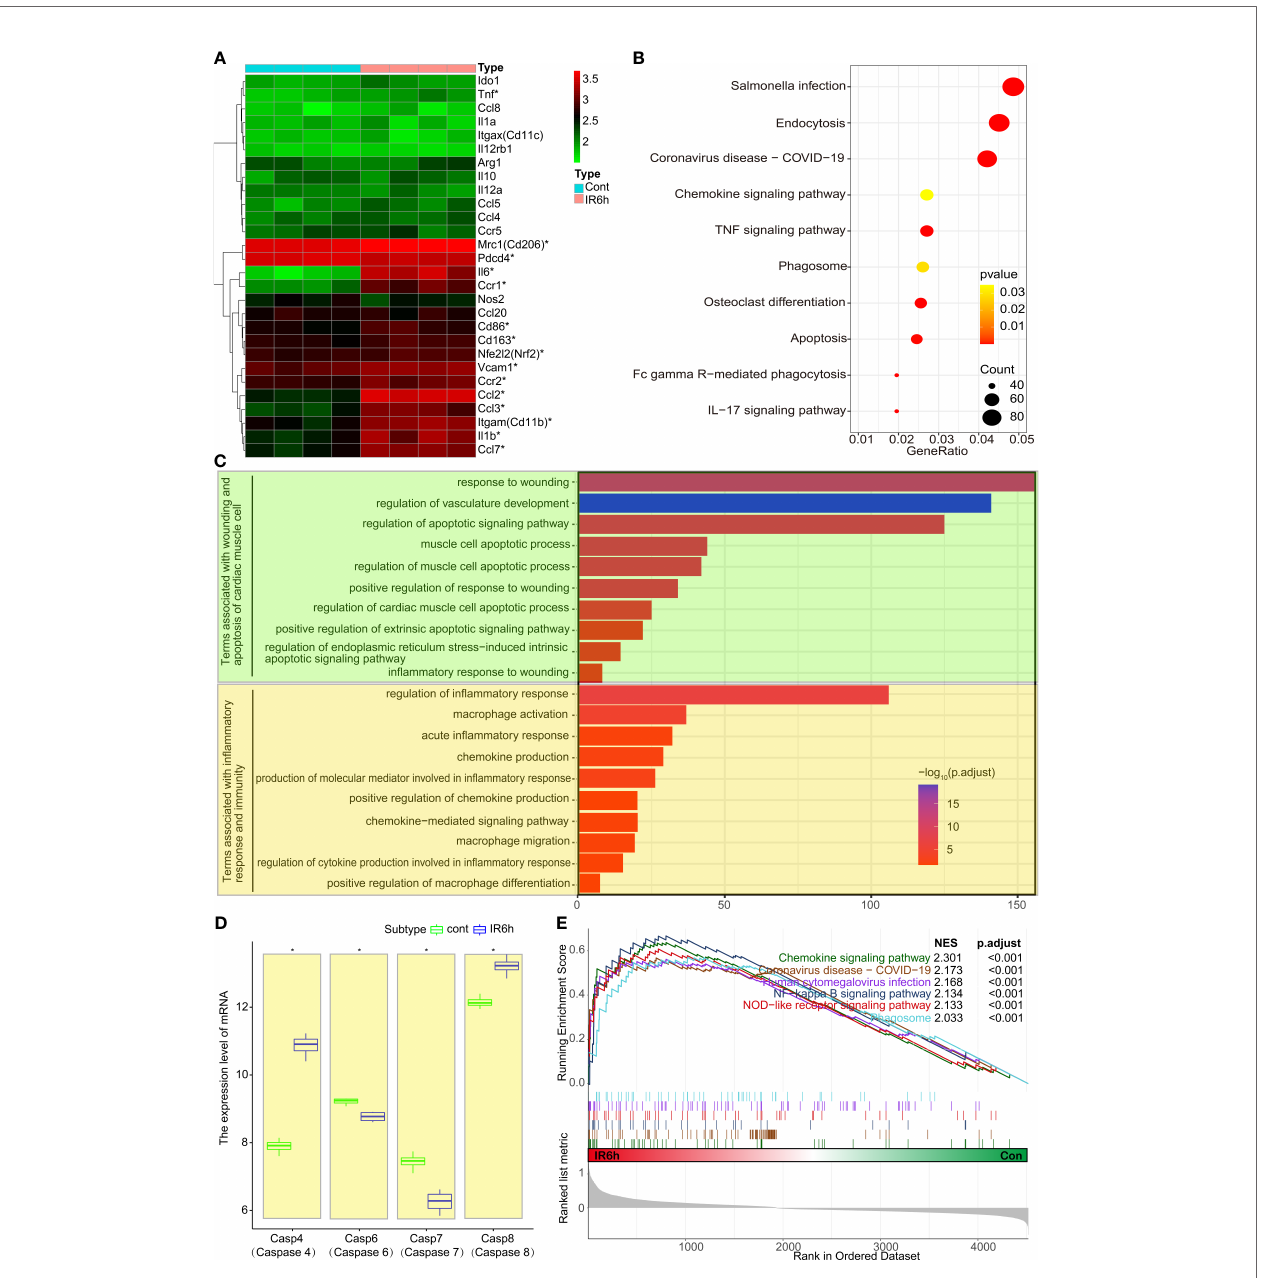
FIGURE 1 | Early myocardial ischemia reperfusion promoted myocardial apoptosis and in fl ammatory response. (A) Heatmap of mouse in fl ammatory genes between the control group and IR6h group, including Nfe2l2 and Pdcd4. (B) KEGG - enriched signaling pathways according to differentially expressed genes. (C) GO-enriched modules of biological processes. (D) Transcriptional level analysis of caspase family members. (E) GSEA-enriched signaling pathway associated with in fl ammation or phagocytosis. IR6h, ischemia/reperfusion treatment for 6 h KEGG, Kyoto Encyclopedia of Genes and Genomes. GO, Gene Ontology. GSEA, Gene Set Enrichment Analysis. *P < 0.05, compared to the control